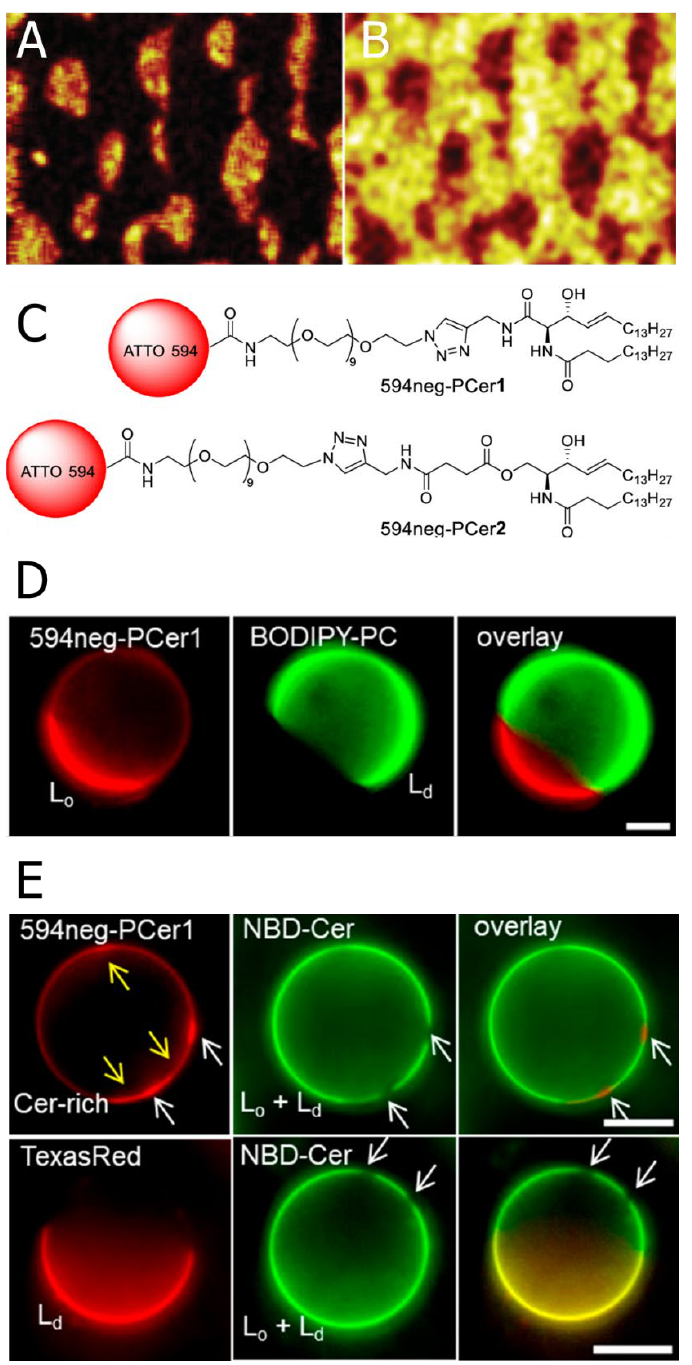
Figure 5. ( A , B ) Time-of-flight secondary ion mass spectrometry (ToF-SIMS) images for C16:0SM/Chol/DOPC/C16:0Cer-d31 (3:2:4:1 molar ratio) monolayers deposited on the substrate at 30 mN/m. ( A ) shows distribution of m/z 2 signals due to deuterium in the negative ion mode that is used to monitor the location of deuterated ceramide. ( B ) shows distribution of m/z 281 signals due to the oleate fragment that was used to monitor DOPC. ( C ) illustrates chemical structures of newly developed fluorescent ceramide analogues 594neg-PCer1 and 594neg-PCer2 (inclusively termed 594neg-PCer). ( D ) Fluorescence micrographs of C16:0SM/Chol/DOPC (1:1:1 molar ratio) ternary component GUVs that underwent phase separation between the Lo and Ld domains. This sample contained 0.2 mol % 594neg-PCer1 and BODIPY-PC (Ld marker). ( E ) Fluorescence micrographs of C16:0SM/Chol/DOPC/C16:0Cer (1:1:1:0.3 mole ratio) quaternary component GUVs. This sample contained (top) 0.2 mol % 594neg-PCer1 and 0.2 mol % NBD-Cer (both Lo and Ld marker) and (bottom) 0.2 mol % Texas Red-DPPE (Ld marker) and 0.2 mol % NBD-Cer. White and yellow arrows